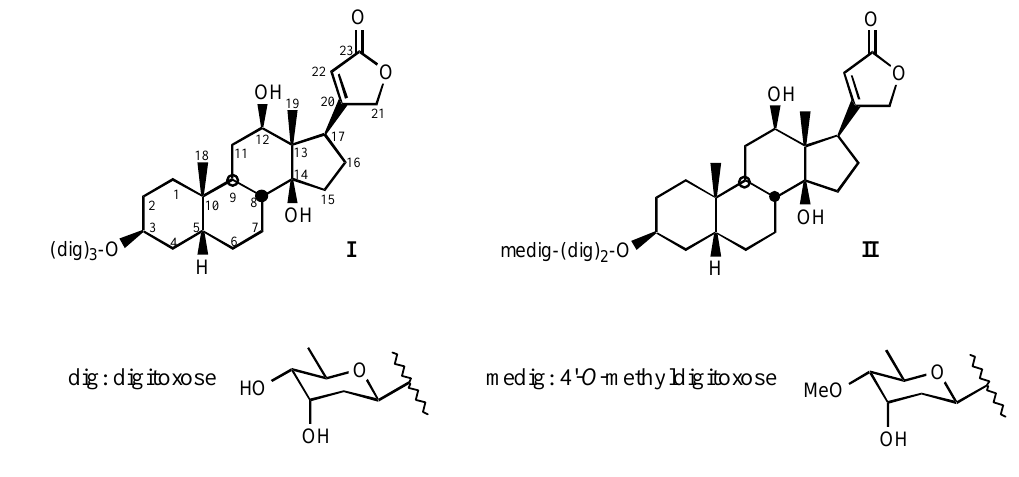
Figure 1. Structure of digoxin ( I ) and methyldigoxin ( II